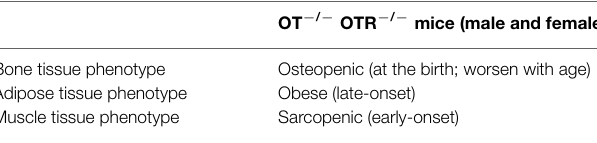
TABLE 1 | Mice phenotype